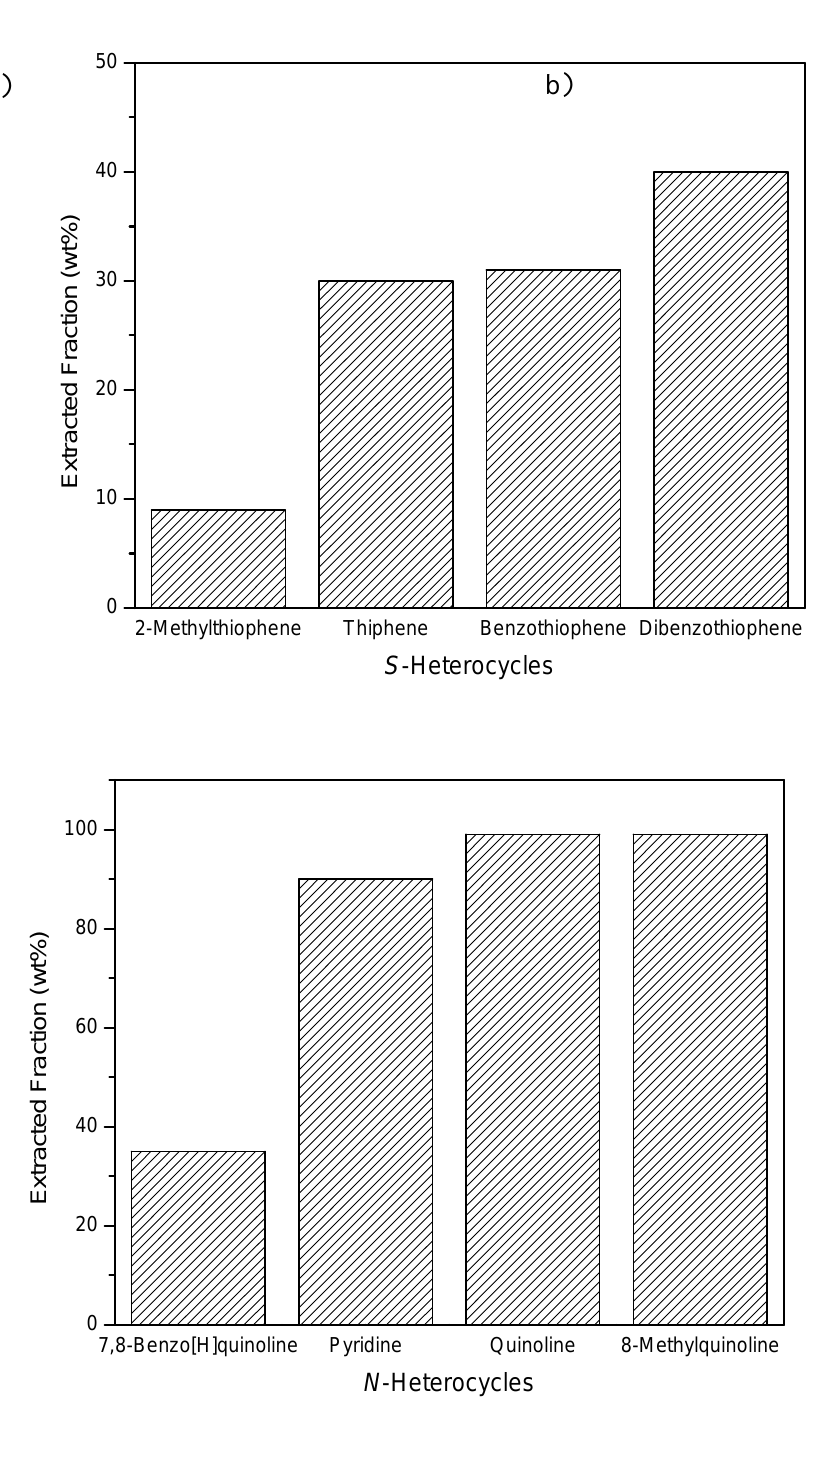
Figure 7. Extracted fractions of (a) S - and (b) N -heterocycles from a 1 wt % solution in n